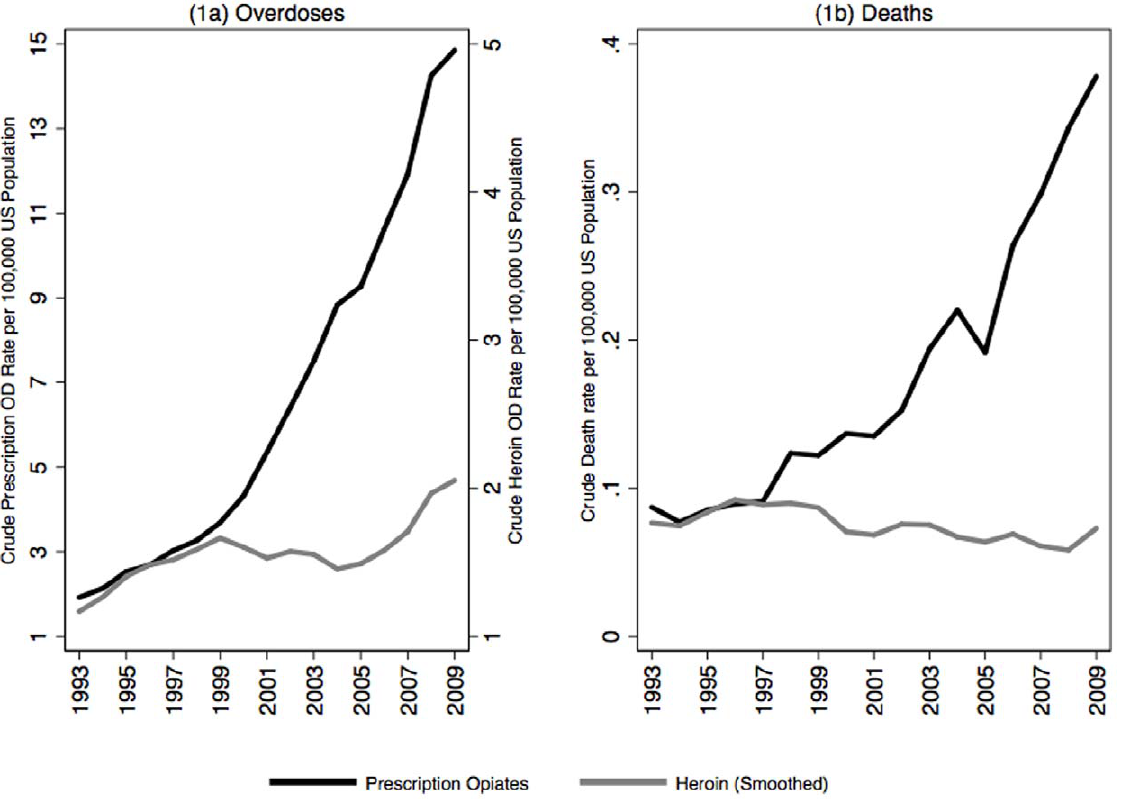
Figure 1. Rates of overdose and death.